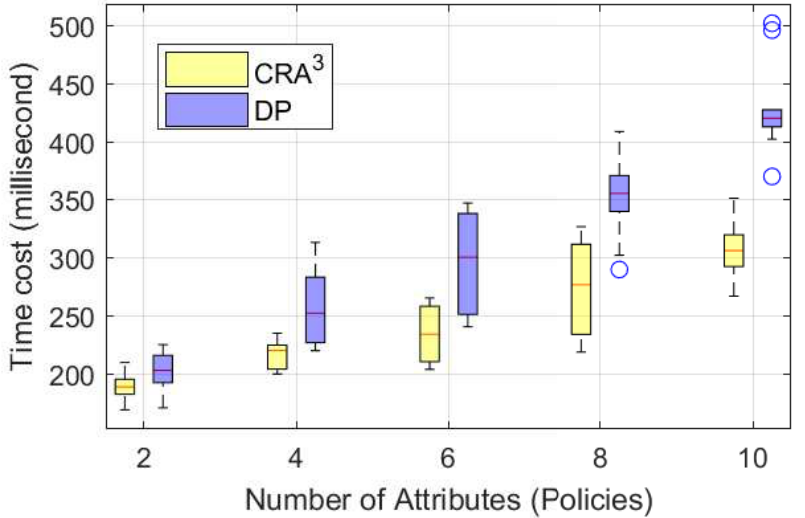
Figure 4. Comparison of the time costs of CRA 3 and DP [12] for transmitting data over